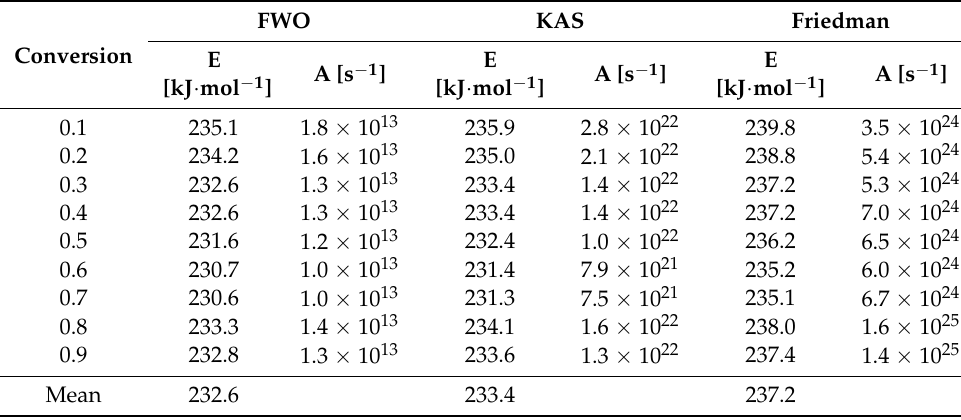
Table 12. Kinetic parameters of TTGA at heating rates of more than 6 min − 1 .